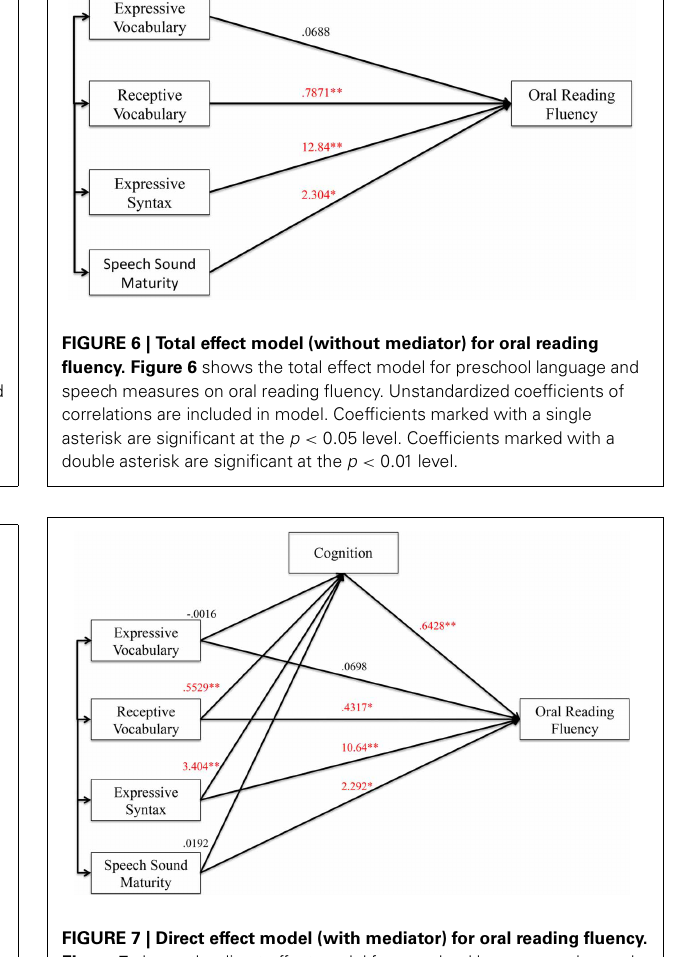
FIGURE 5 | Direct effect model (with mediator) for reading comprehension. Figure 5 shows the direct effect model for preschool language and speech measures on reading comprehension with cognition as the mediator. Unstandardized coefficients of correlations are included in model. Coefficients marked with a double asterisk are significant at the p < 0 . 01 level.